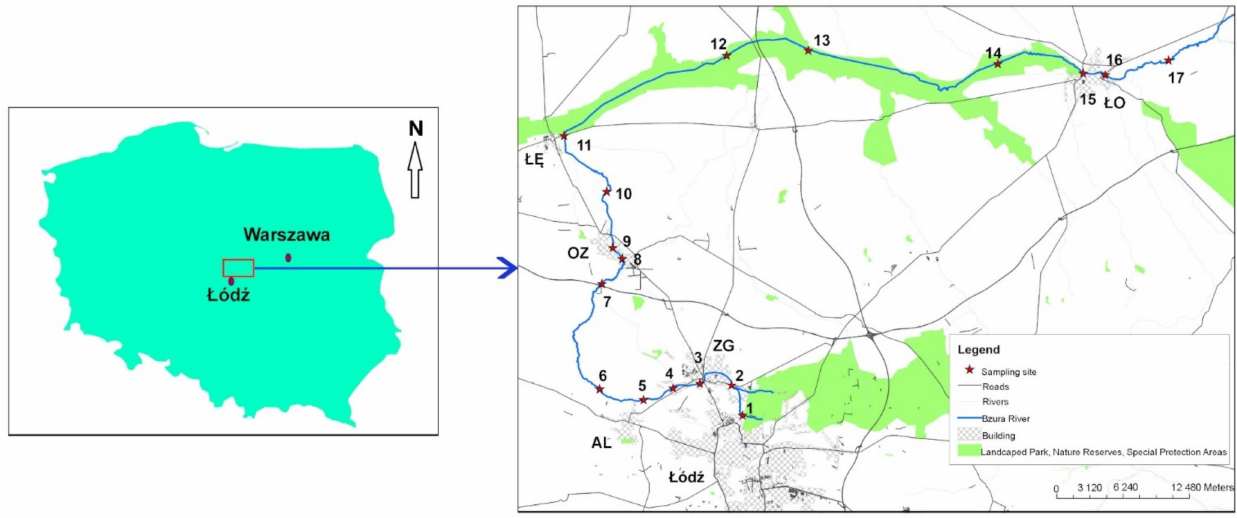
Figure 1. Location of the sampling sites and main towns within the study area (ZG—Zgierz; AL—Aleksandr ó w Ł ó dzki; OZ— Ozork ó w; Ł ˛E—Ł˛eczyca; ŁO—Łowicz). The location of sampling sites was determined by handheld GPS (MobileMapper 50, Spectra Geospatial, Westminster, CO, USA). The map of the area was generated using ArcMap 9.2 (Esri, Redlands, CA, USA) software, basic geographic data was acquired from the Head Office of Land Surveying and Cartography